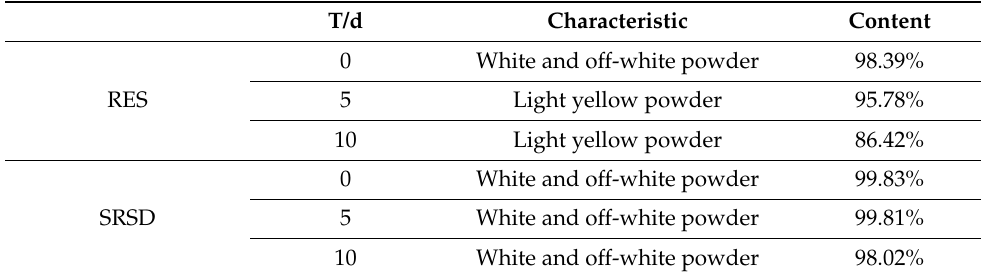
Table 8. The character and content under strong light.